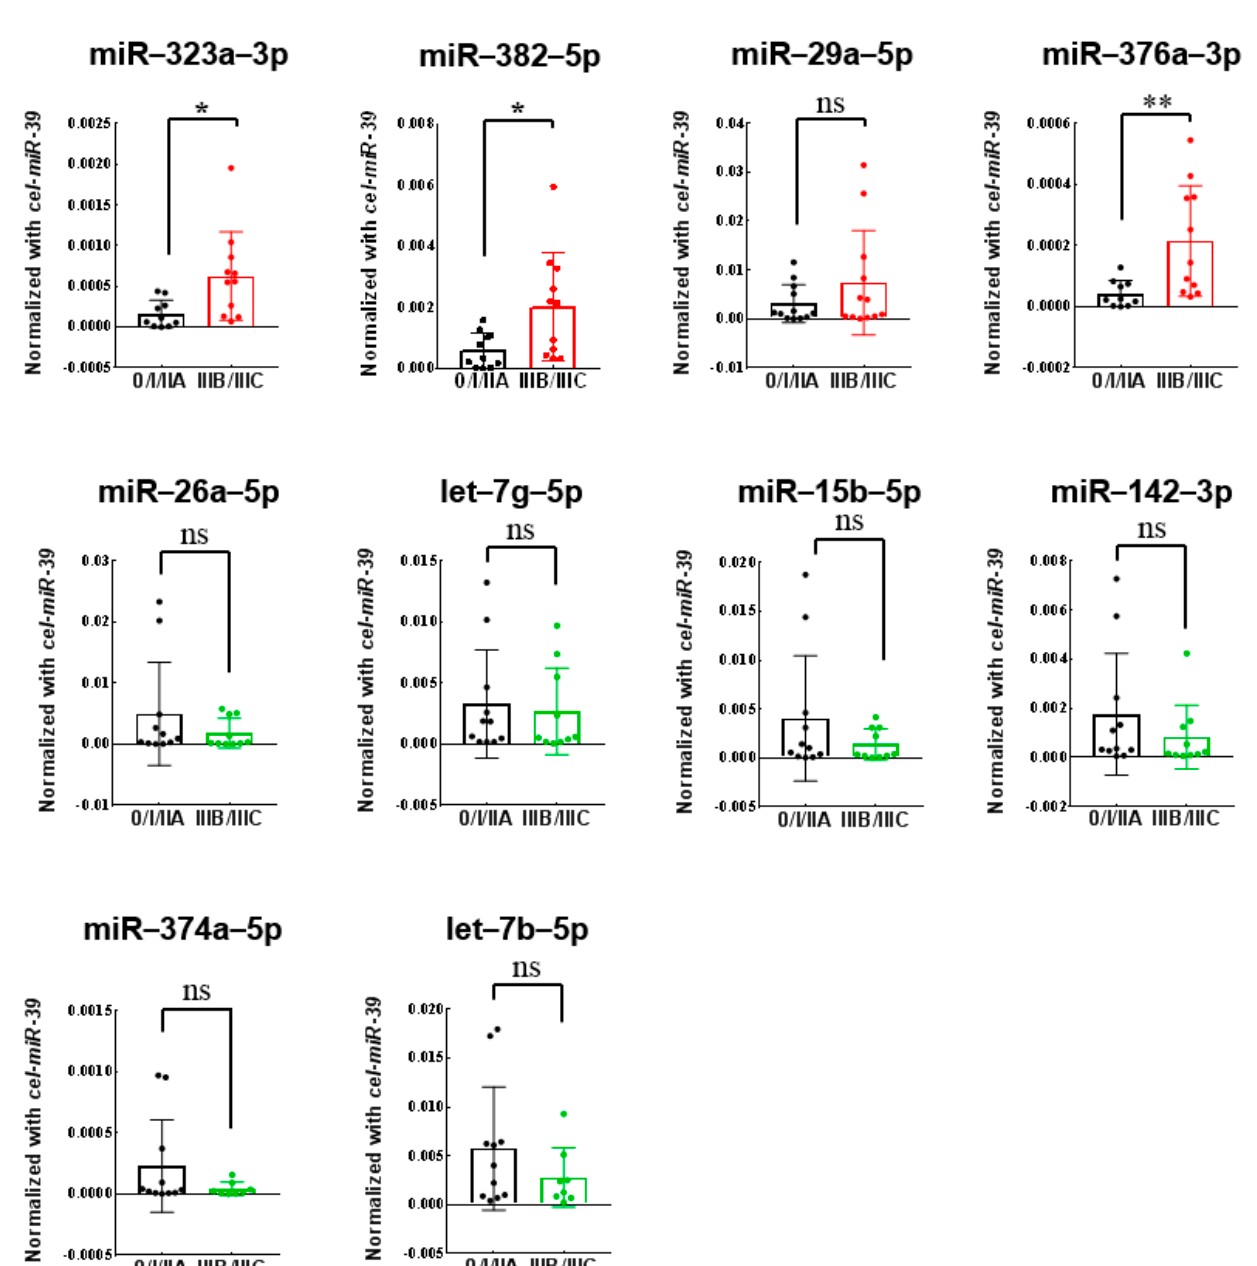
Figure 1. Analysis of 24 plasma samples from colon cancer patients using quantitative real-time polymerase chain reaction (RT-PCR) (discovery cohort, stage 0/I/IIA vs. IIIB/IIIC). miR-323a-3p (* p = 0.0177), miR-382-5p (* p = 0.0178), miR-29a-5p ( p = 0.1331), miR-376a-3p (** p = 0.0084), miR-26a-5p ( p = 0.2709), let-7g-5p ( p = 0.7410), miR-15b-5p ( p = 0.2186), miR-142-3p ( p = 0.3050), miR-374a-5p ( p = 0.1854), let-7b-5p ( p = 0.2405).